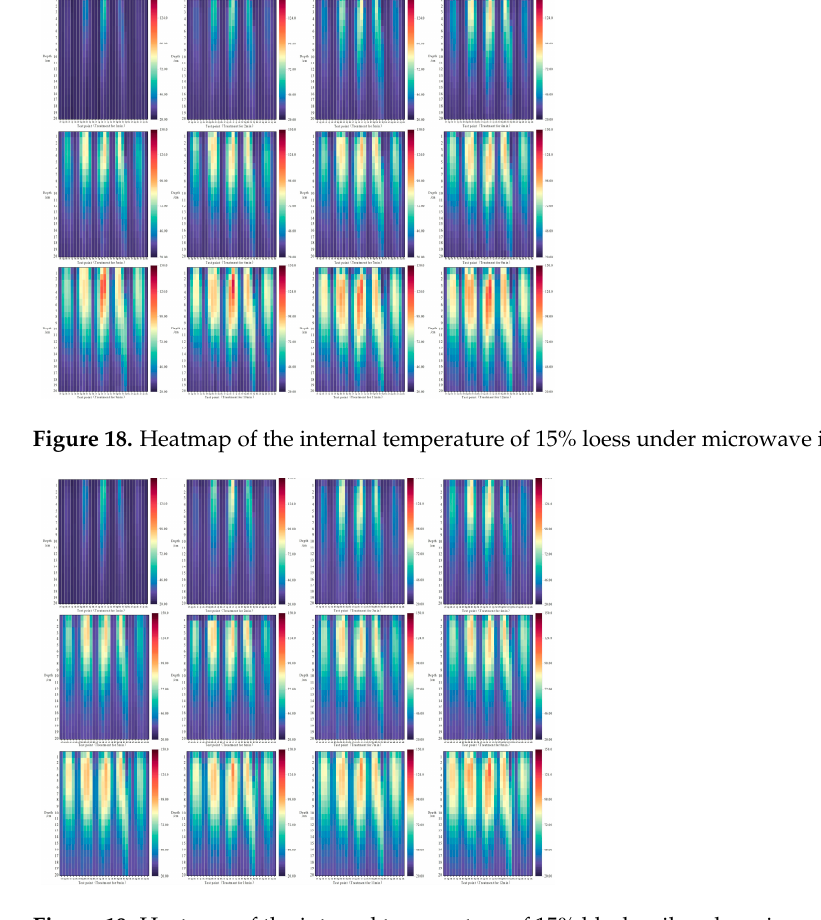
Figure 20. Heatmap of the internal temperature of 20% loess under microwave irradiation. Figure 21. Heatmap of the internal temperature of 20% black soil under microwave irradiation.